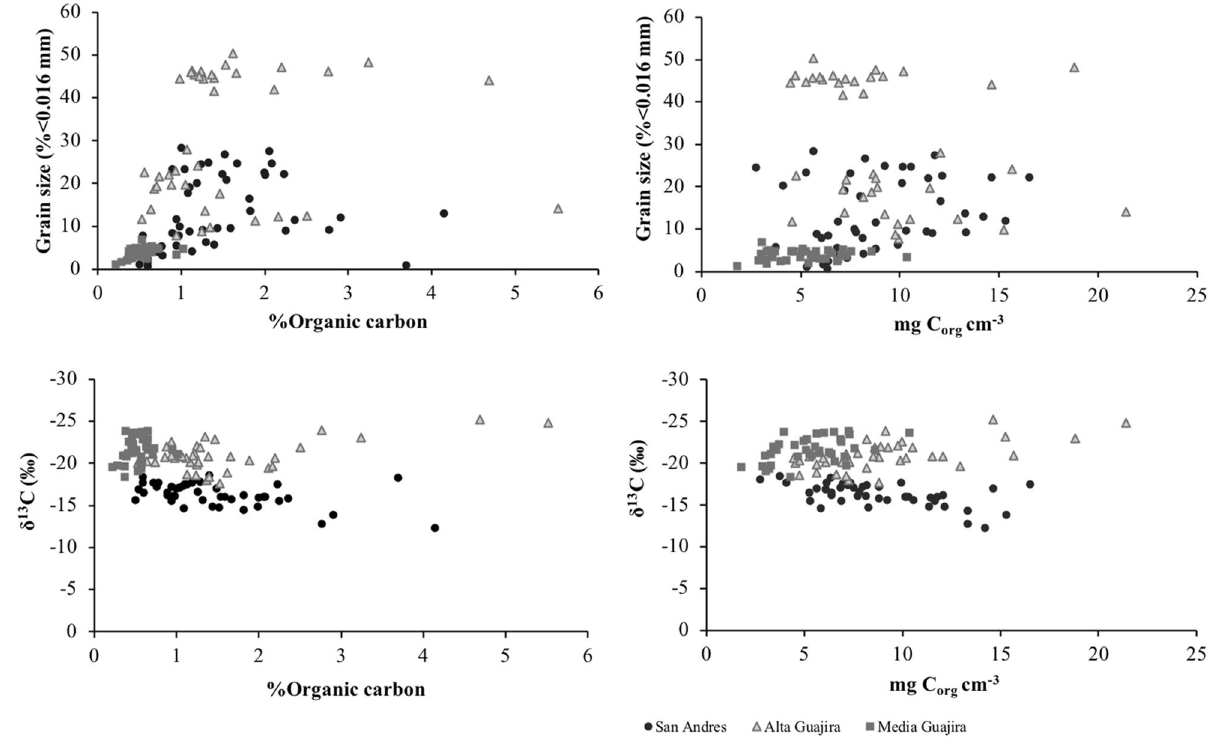
Figure 3. Relationships between soil organic carbon content (% C org and mg C org cm −3 ) and sediment particles < 0.016 mm and δ 13 C (‰) in the seagrass cores from San Andrés, Cartagena Bay and La Guajira in the Colombian Caribbean.